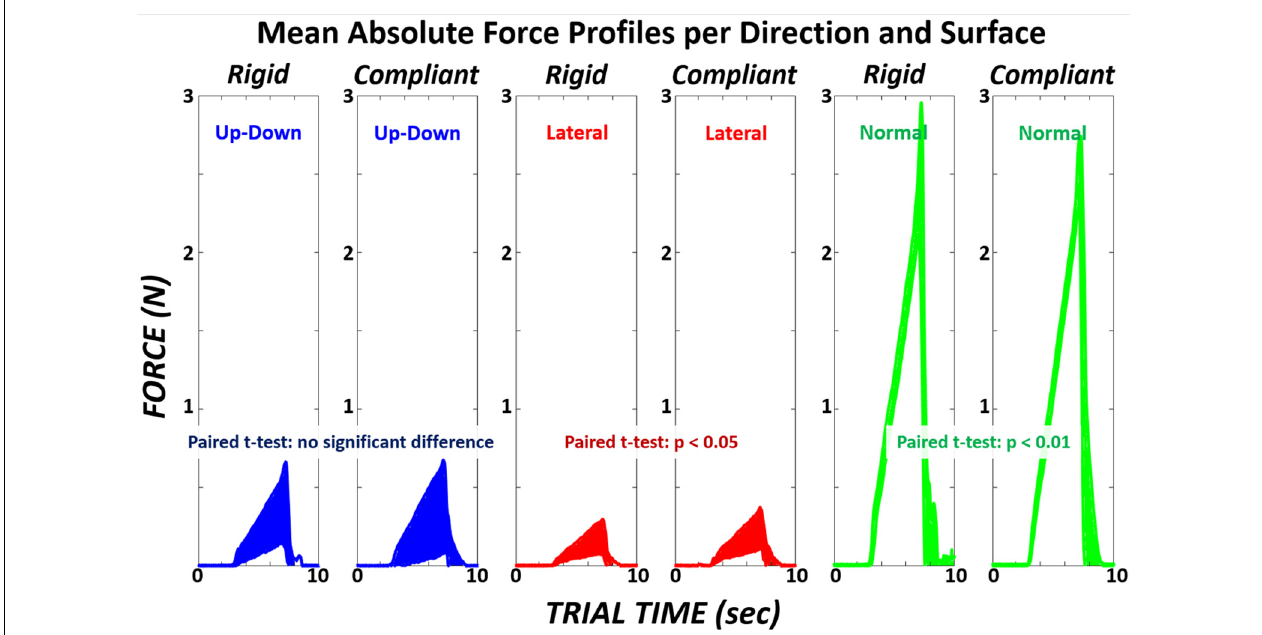
FIGURE 8 | Mean absolute force profile across the 10-s trial for a single digit shown in each dimension ( up-down, lateral, normal ) for rigid versus compliant surfaces. Profile thickness indicates ± 1standard deviation. Paired t -test performed across the average variability (standard deviation) for each dimension during ramp period ( t trial = 3–7 s). The mean force variability in each dimension for the rigid surface was 0.294 , 0.098 , and 0.256 N . The mean force variability in each dimension for the compliant surface was 0.291 , 0.142 , and 0.173 N